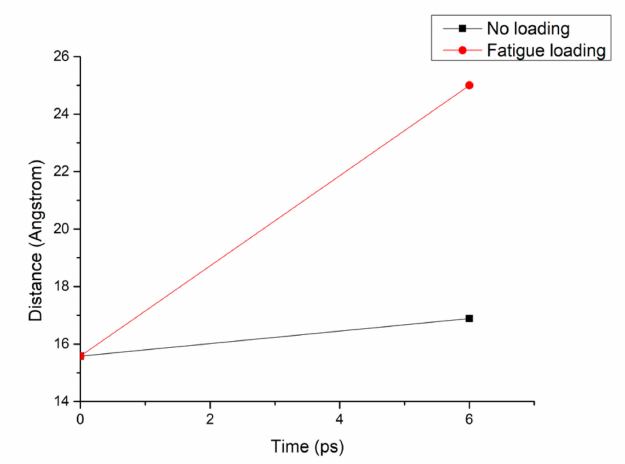
Figure 8. Pore diameter change of the C-S-H structure under di ff erent working